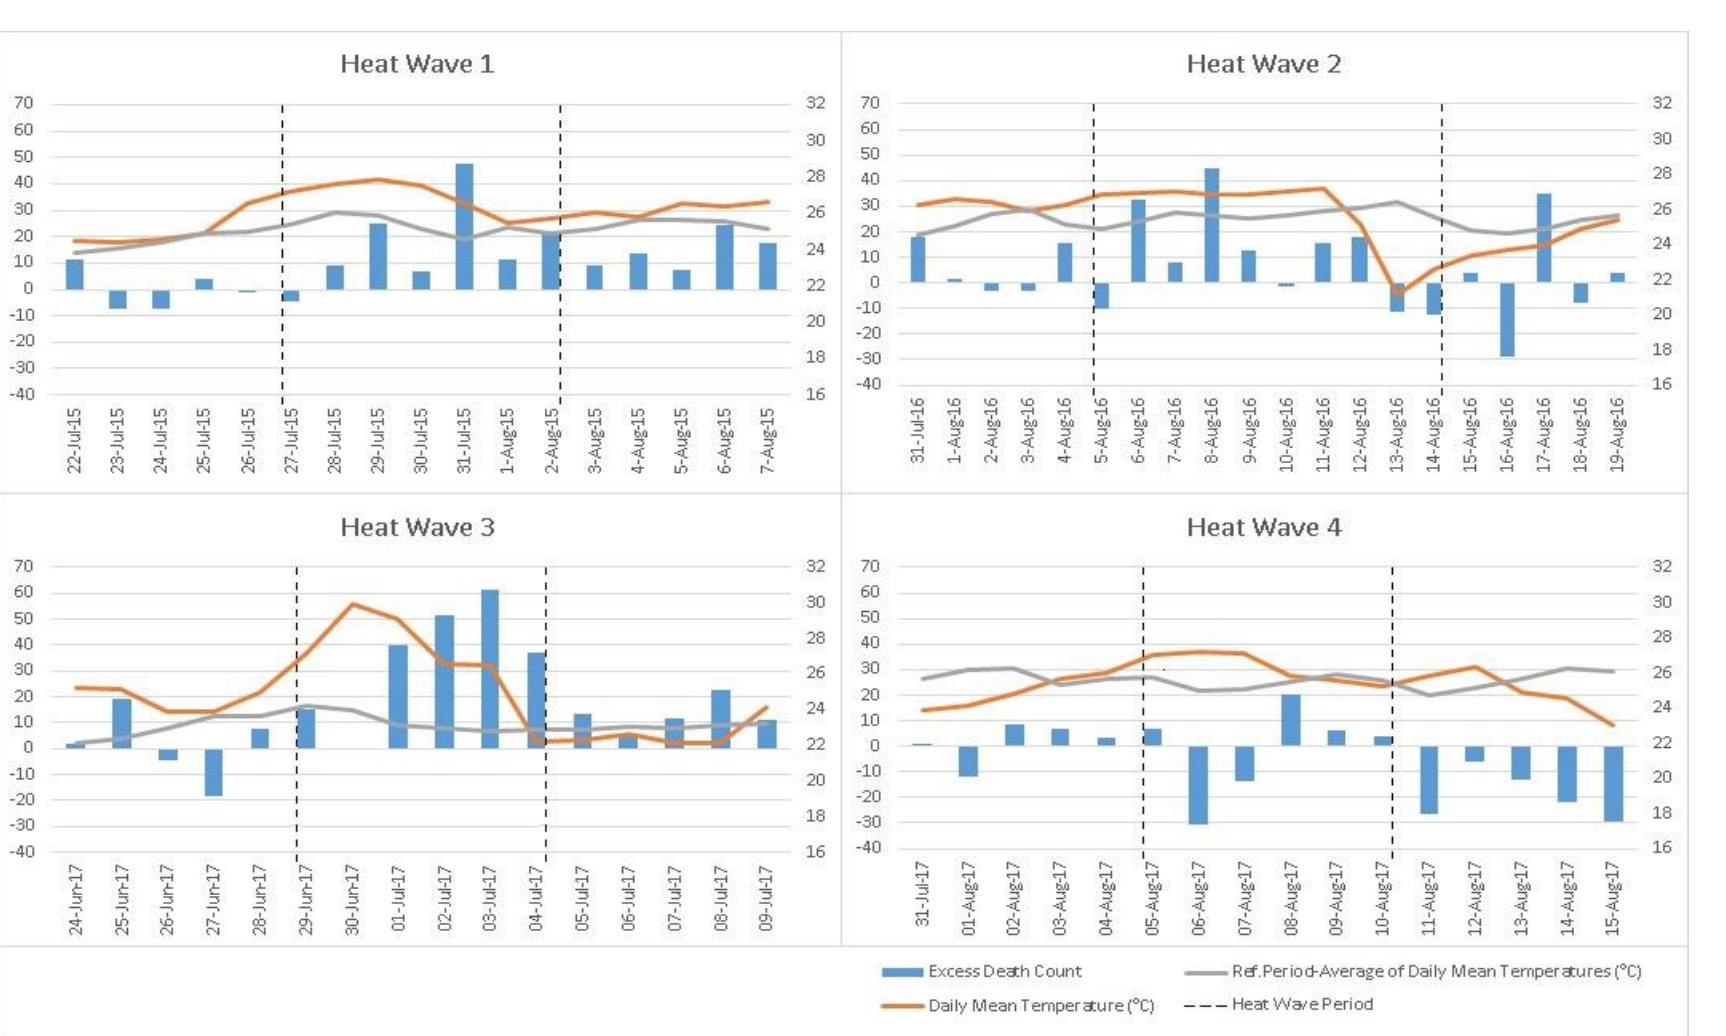
Figure 1. Excess death counts, daily mean temperatures, and temperature of reference periods for the Extreme Heat Waves between 2013